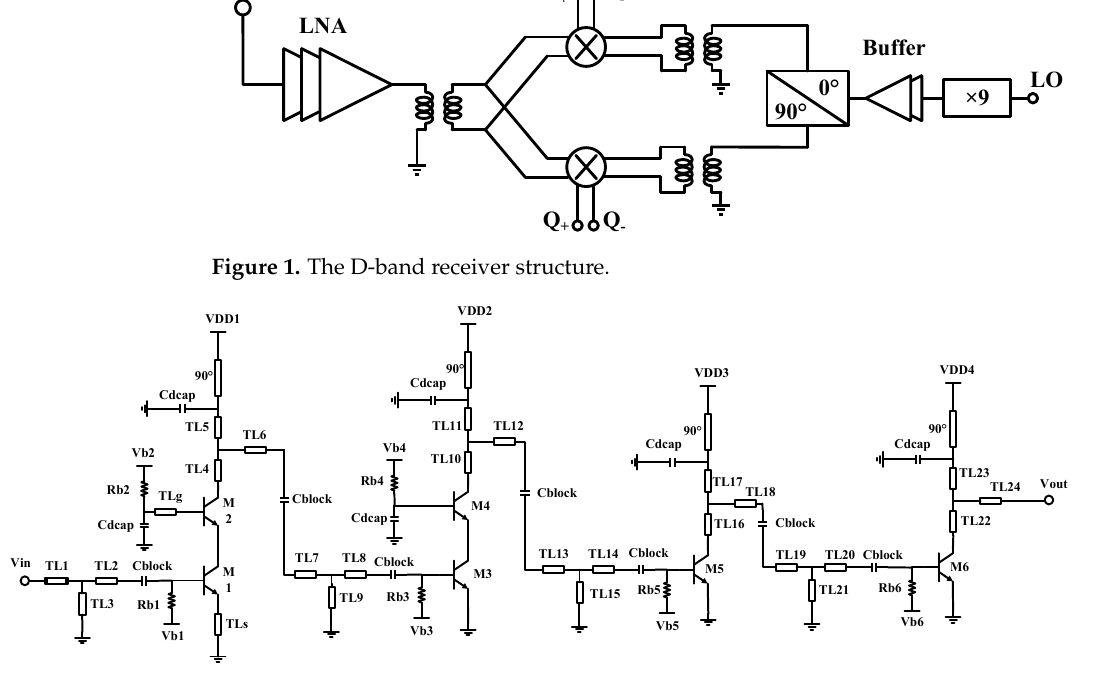
Figure 2. The schematic of the proposed wideband LNA.